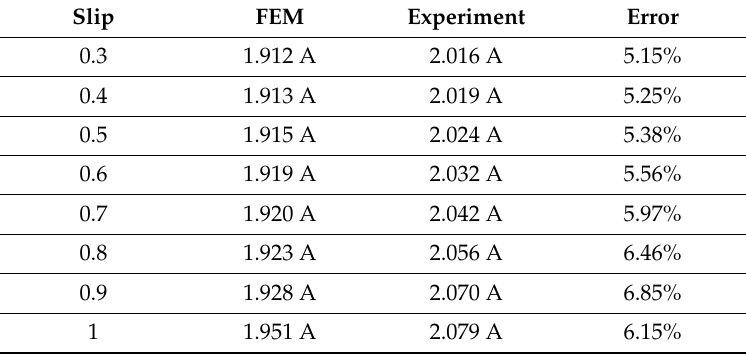
Figure 15. Torque-slip curve and no-load current of FEM and experiment. Table 6. Stator current of FEM and